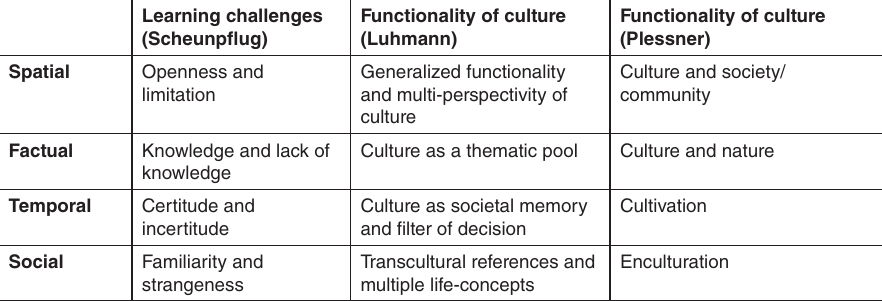
Table 2: Learning challenges and